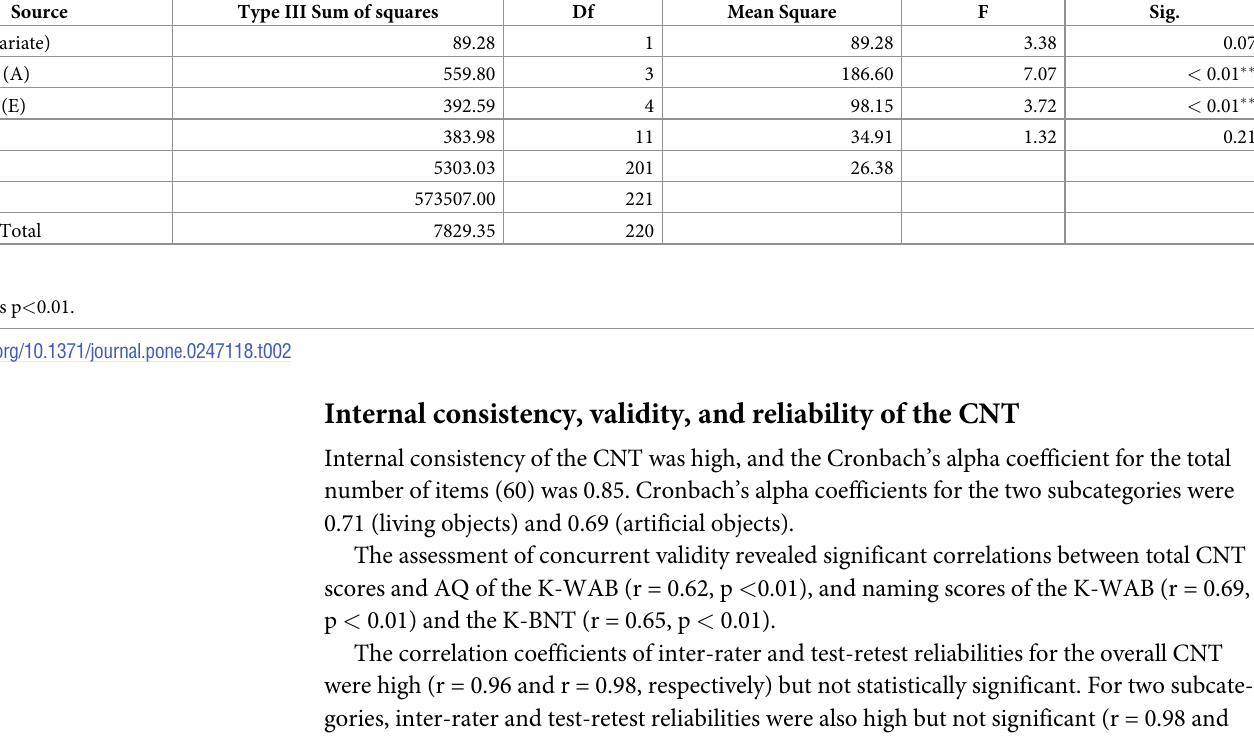
Table 2. Two-way ANCOVA results for total categorical naming test scores in healthy controls (N = 221). Source